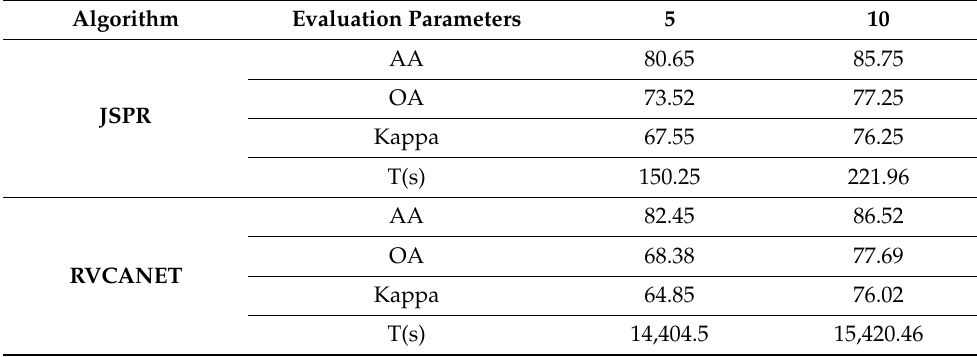
Table 4. Comparison of classification accuracies (%) of different algorithms for the PaviaU